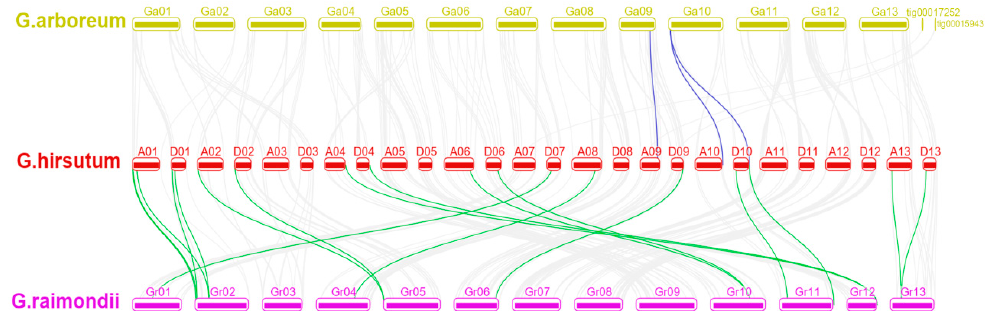
Figure 2. Synteny analysis of NACs in cotton. The grey lines indicate NACs collinear relationship in three genomes and color lines indicate that only in two genomes. Ga: Gossypium arboreum , Gr: Gossypium raimondii , A/D: A/D subgenome of Gossypium hirsutum . The numbers indicate chromosome number. Tig means contig.